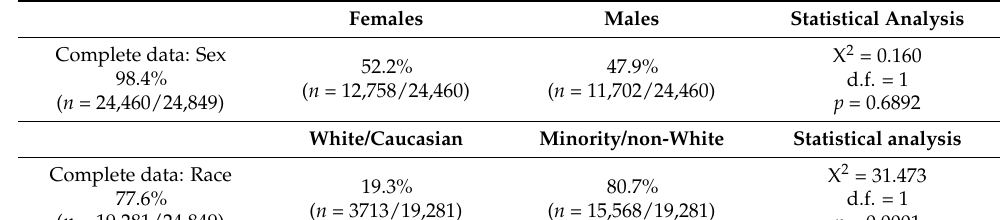
Table 1. Demographic analysis of study